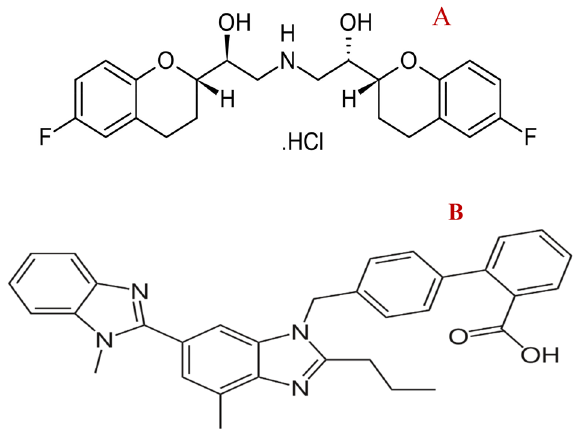
Figure 1. Structural Formulae of ( A ) Nebivolol HCl, ( B )